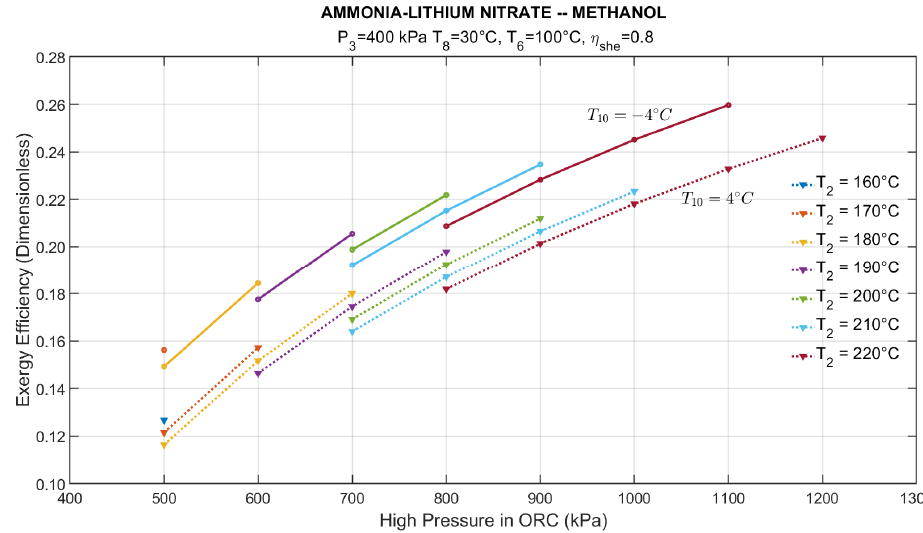
Figure 14. NH 3 -LiNO 3 –CH 3 OH exergy efficiency as a function of heat supply temperature and maximum ORC pressure.